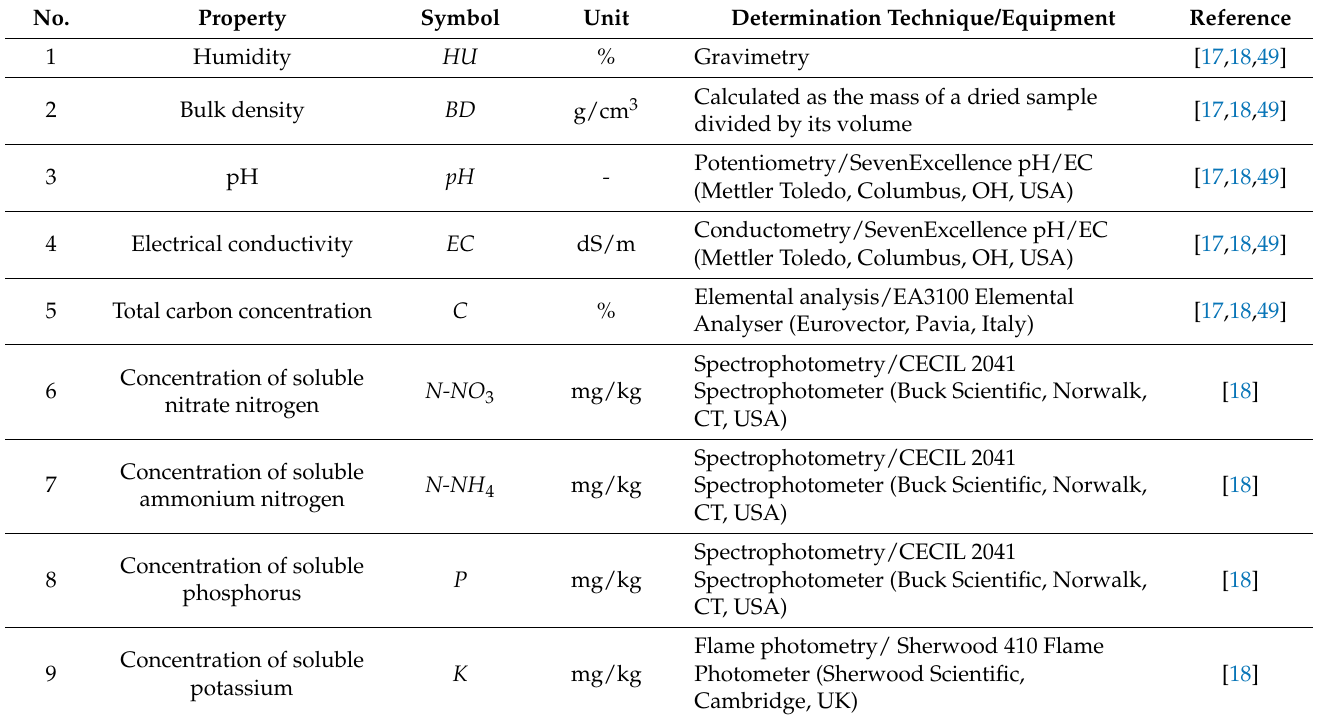
Table 2. Relevant physicochemical properties of BC, non-amended and BC-amended soils with their symbols, units, determination techniques and